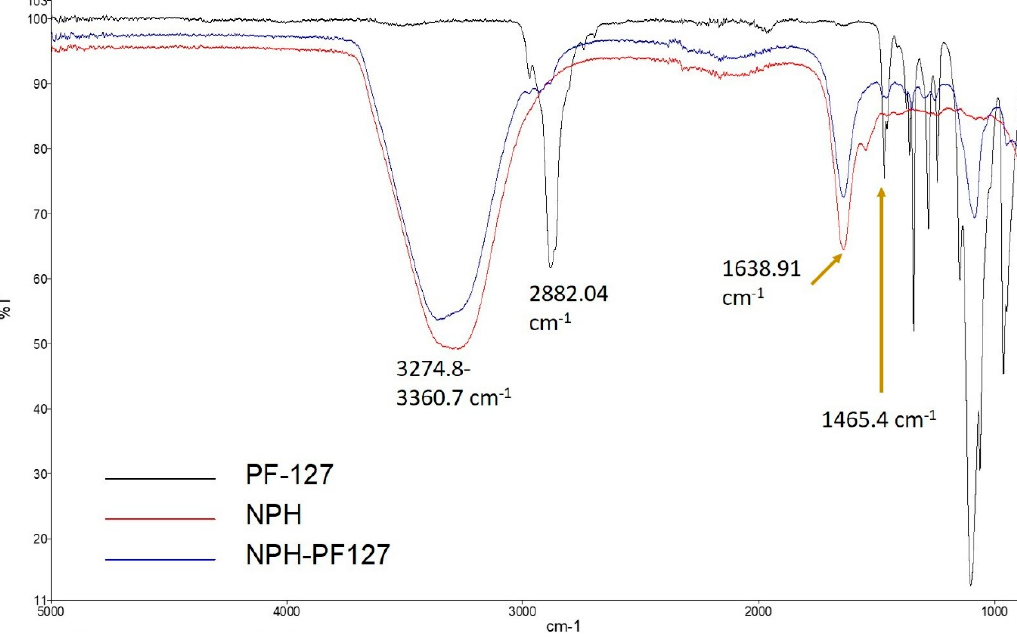
Figure 3. FTIR spectra of NPH, NPH/PF127, and PF127.